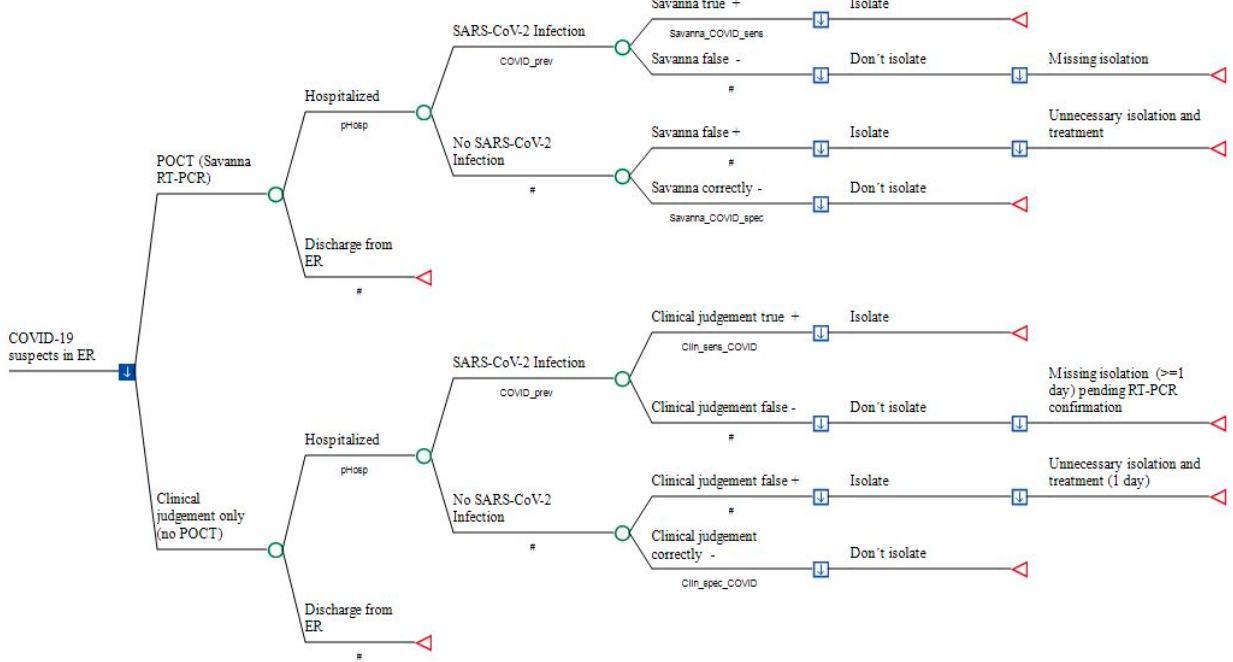
Figure 1. Point-of-Care antigen Testing (POCT) versus the conventional approach in COVID-19 suspects prior to hospitalization. Legend: a decision node (square) indicates a choice facing the decision-maker or the consequences of a decision. Branches from a chance node (circles) represent the possible outcomes of an event; terminal nodes (triangles) denote the endpoints of a scenario and are assigned in Table 2. Savanna_COVID_sens: sensitivity of Savanna ® Multiplex RT-PCR; Savanna_COVID_spec: specificity of Savanna ® Multiplex RT-PCR testing; Clin_sens_COVID: sensitivity of diagnosing SARS-CoV-2 infection; Clin_spec_COVID: probability of correctly excluding SARS-CoV-2. #: Complementary probability (all probabilities of chance node’s branches to sum to 1.0); +: positive; − : negative. Table 2. Results of the base-case analysis (no confirmation of Savanna ® results by external RT-PCR).